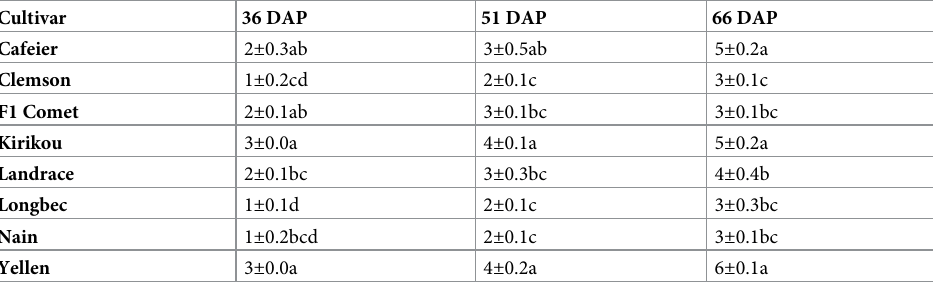
Values with the same letter in a column are not significantly different from each other under Tukey test at a 5% probability level.